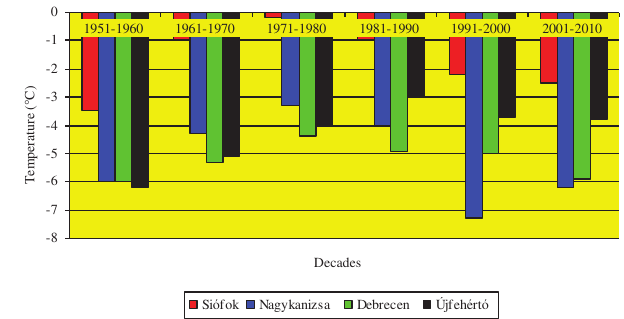
Figure 3 – The occurrence of absolute minimum temperatures during the blooming season in four regions, as appearing in every decennium over the 60 year long period: 1951–2010